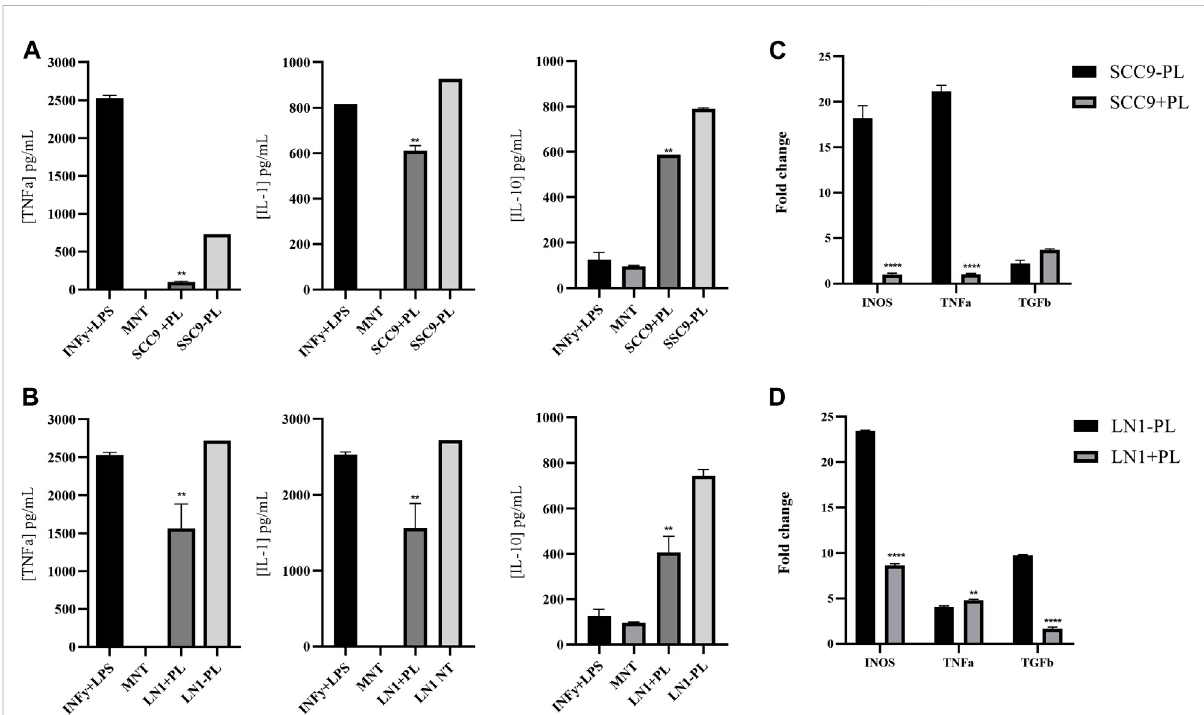
FIGURE 4 Immuno-in fl ammatory tumor response associated with OSCC cells treated with PL. Showing quanti fi cation of the cytokines IL-1, IL-10 and TNF-alfa produced by macrophages conditioned with tumoral media treated with PL (A-B) . Incubation with both SCC9 (A) and LN1 (B) cells treated with PL signi fi cantly decreased the secretion of TNF-alfa (SCC9, p < 0.001; LN1, p < 0.01) and IL-1 (SCC9, p < 0.01; LN1, p < 0.01). Gene expression analysis of Macrophages incubated with SCC-9 tumoral media treated with PL showed signi fi cant upregulation of TGF-beta, and downregulation of TNF-alfa and iNOS, compared to tumoral media not treated with PL (C) . Expression analysis of Macrophages incubated with LN1 tumoral media treated with PL showing signi fi cant downregulation of TGF-beta and iNOS (D) . The graphs compile experimental duplicate analyses, and the results were obtained by ANOVA followed by Tukey assay, where ** p < 0.01, and **** p <